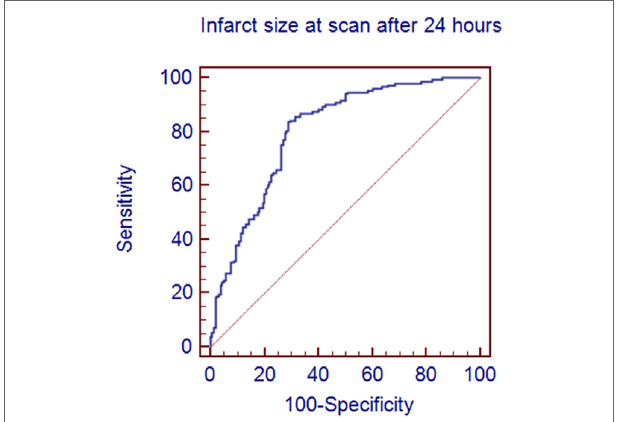
FigUre 2 | A receiver operator characteristics analysis showing the sensitivity and specificity of predicting a good outcome on the basis of the size of the infarct on the 24-h scan. An infarct < 52 ml predicted a good outcome with a sensitivity of 84.3% and a specificity of